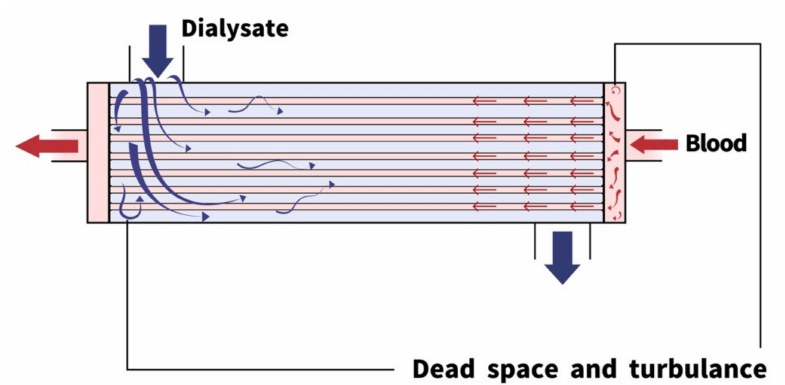
Figure 1. Modern design of the artificial kidney: the geometric designs of the modern artificial kidney are predominantly hollow-fibered. Low fluid resistance and expanded surface area facilitated the efficiency of dialysis. However, the complicated structure creates multiple dead spaces and turbulence within both